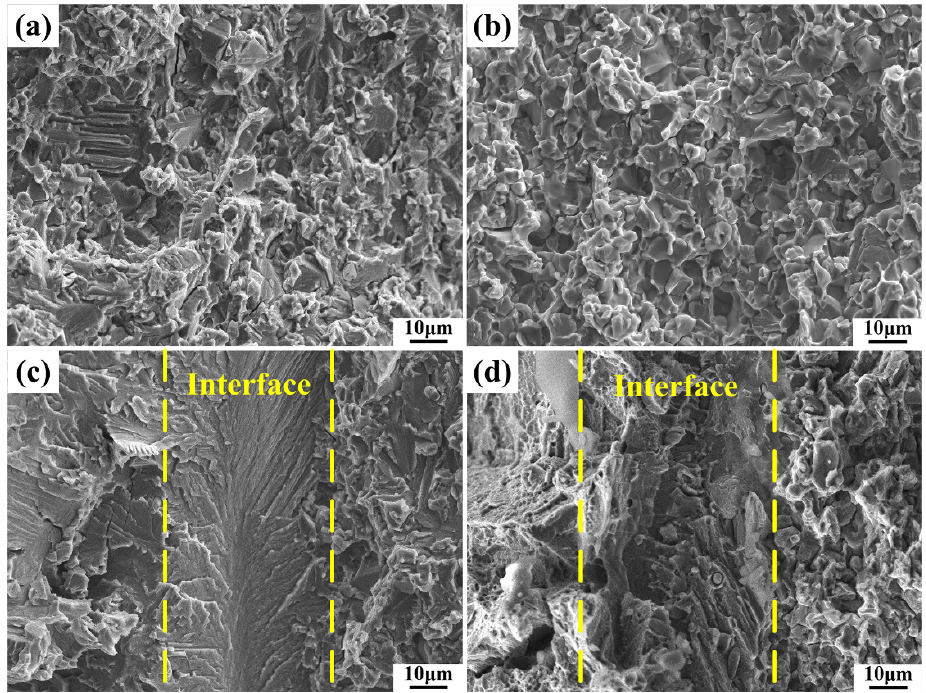
Figure 9. 25 °C fracture morphology of the initial and heat-treated TiAl alloy and interfacial region: ( a ) TiAl alloy and ( c ) interfacial region of initial composite; ( b ) TiAl alloy and ( d ) interfacial region of HT3.